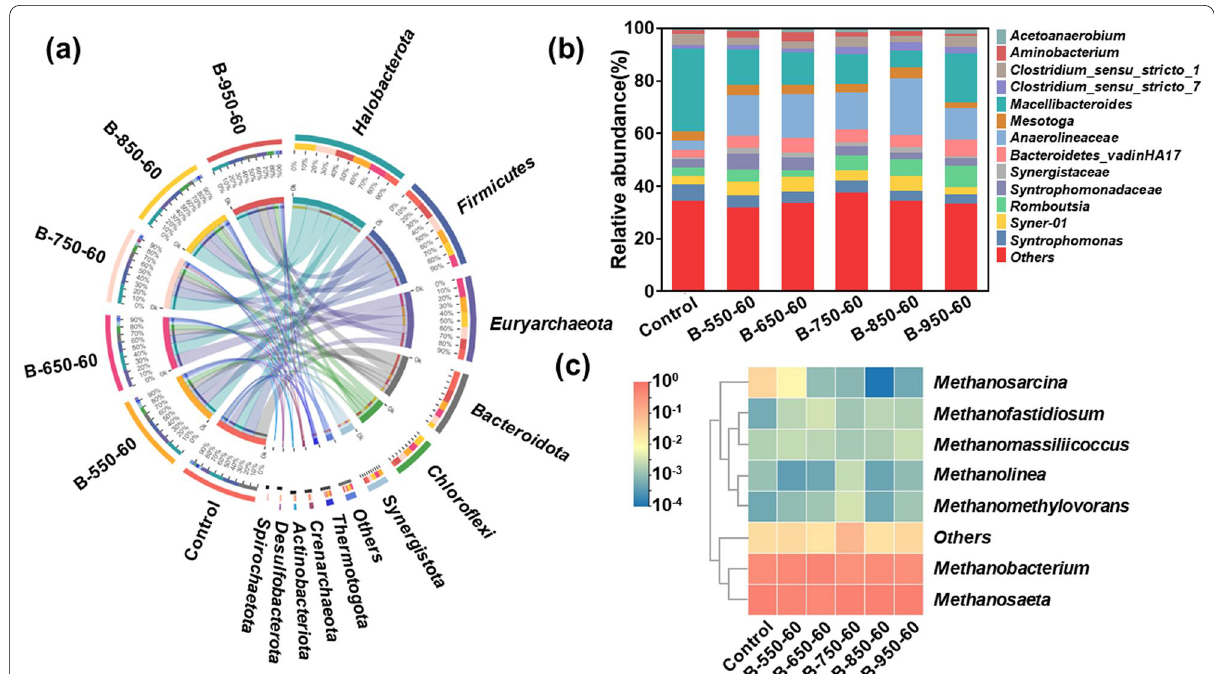
Fig. 4 Microbial community composition of all reactors: a phylum-level classification of the samples; b bacterial genera; c Archaeal